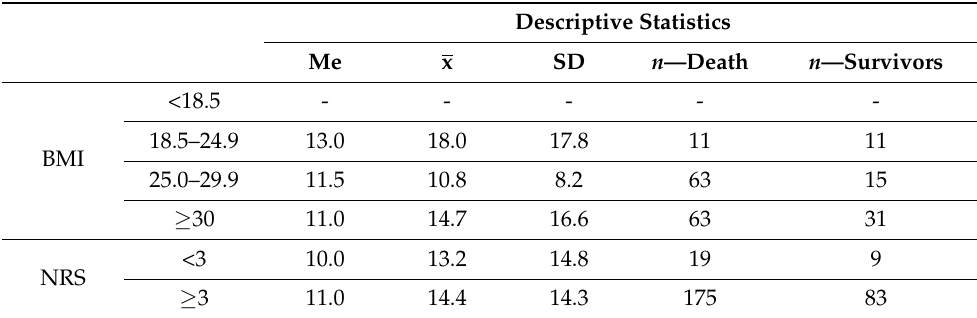
Table 7. Descriptive statistics for survival time, number of deaths and survival according to BMI and NRS scores.